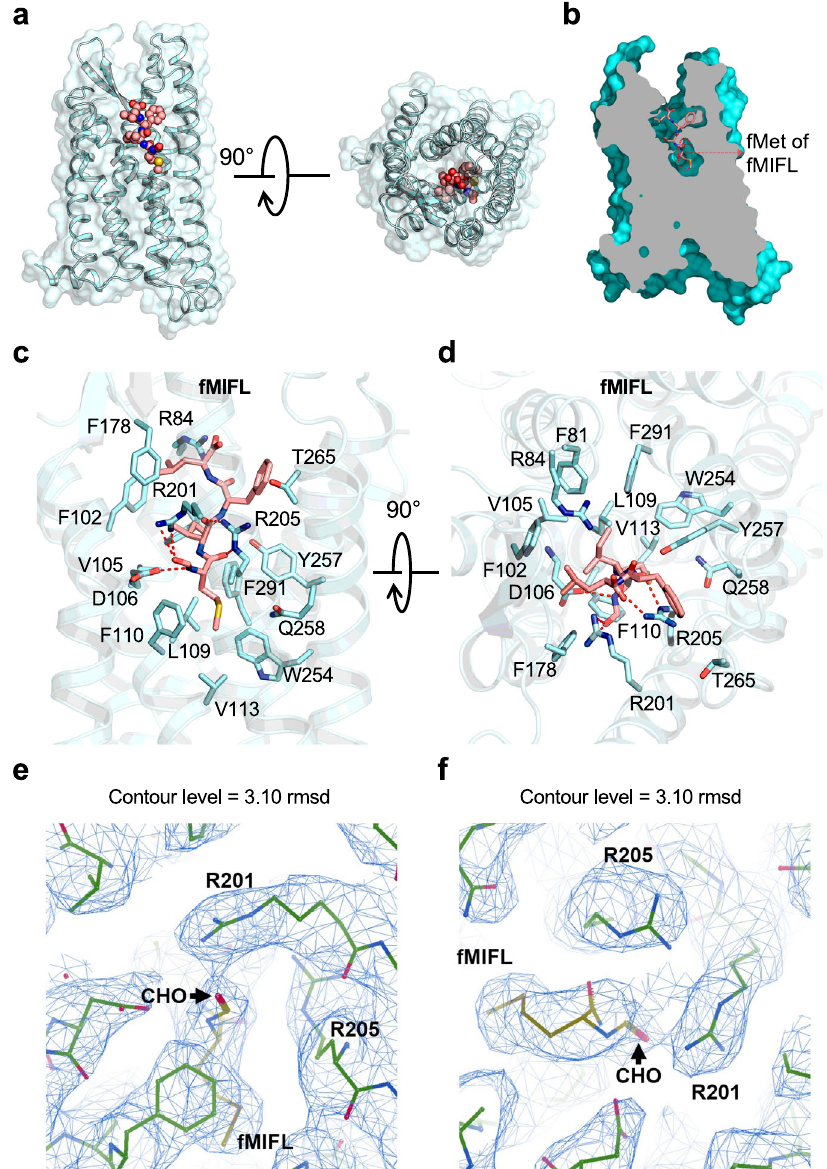
Fig.2|LigandbindingmodeofFPR1tofMIFL.a Sideview(left)andextracellular view (right) of the FPR1-fMIFL structure. The receptor is shown as surface and cartoon,coloredincyan.TheligandfMIFLisshownasspherewithcarbonsinpink. b Slab view (light gray) of the binding cavity of fMIFL in FPR1. fMIFL assumes an N-terminus-in pose circled in red dashed line. c Side view of the binding pocket of FPR1-fMIFLstructure.Thereceptorisshownascartoonandcoloredinmarineblue. TheligandfMIFLisshownaslicoricewithcarbonsinpink.Hydrogenbondsformed